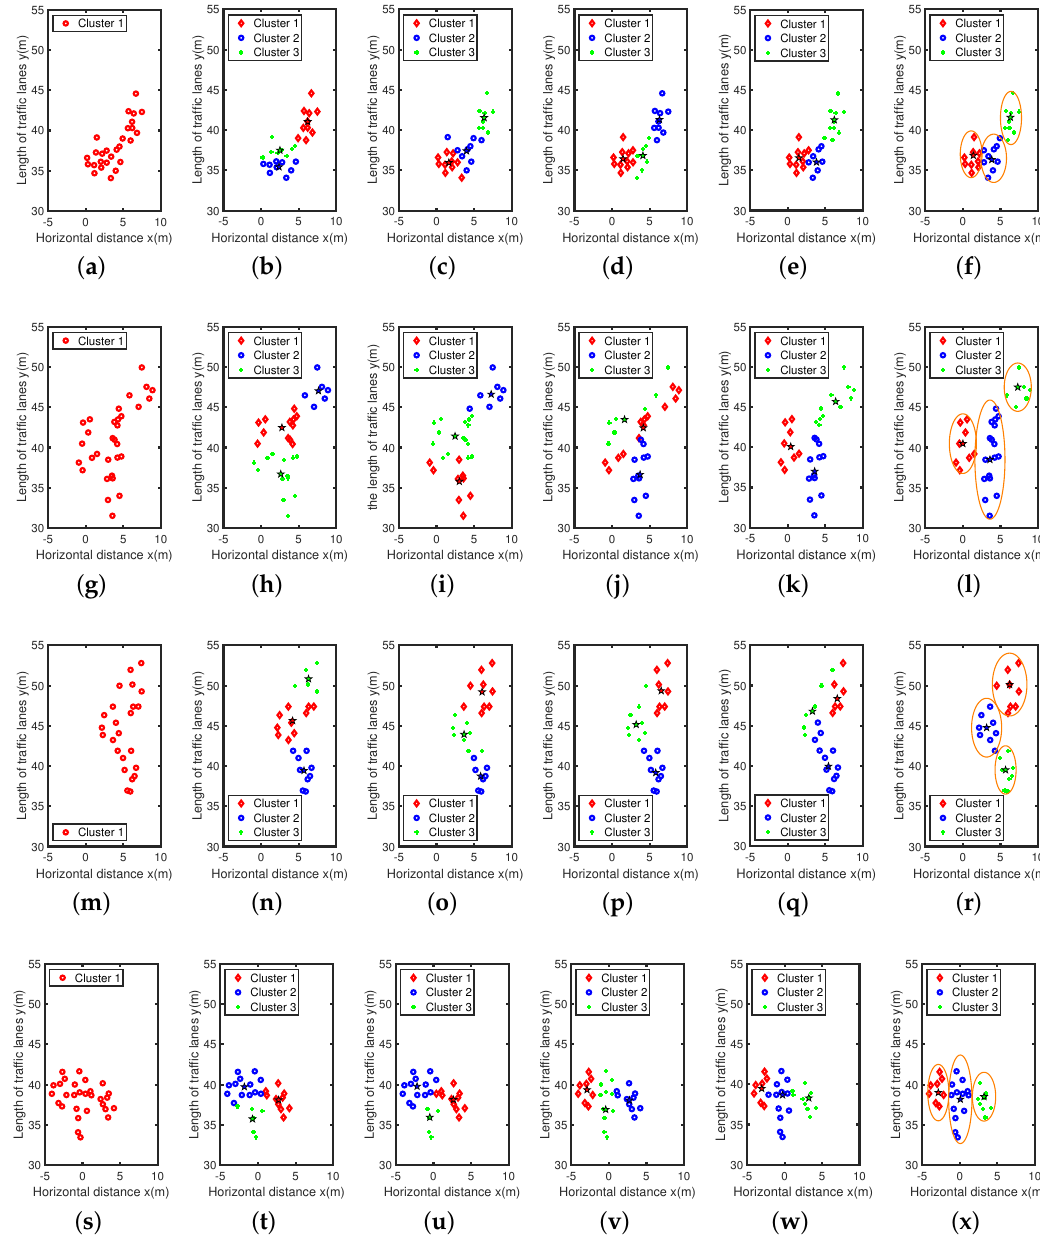
Figure 9. Clustering results of DBSCAN, k -means, FCM, GK, Euclid-ADDPF, and AEDDPF